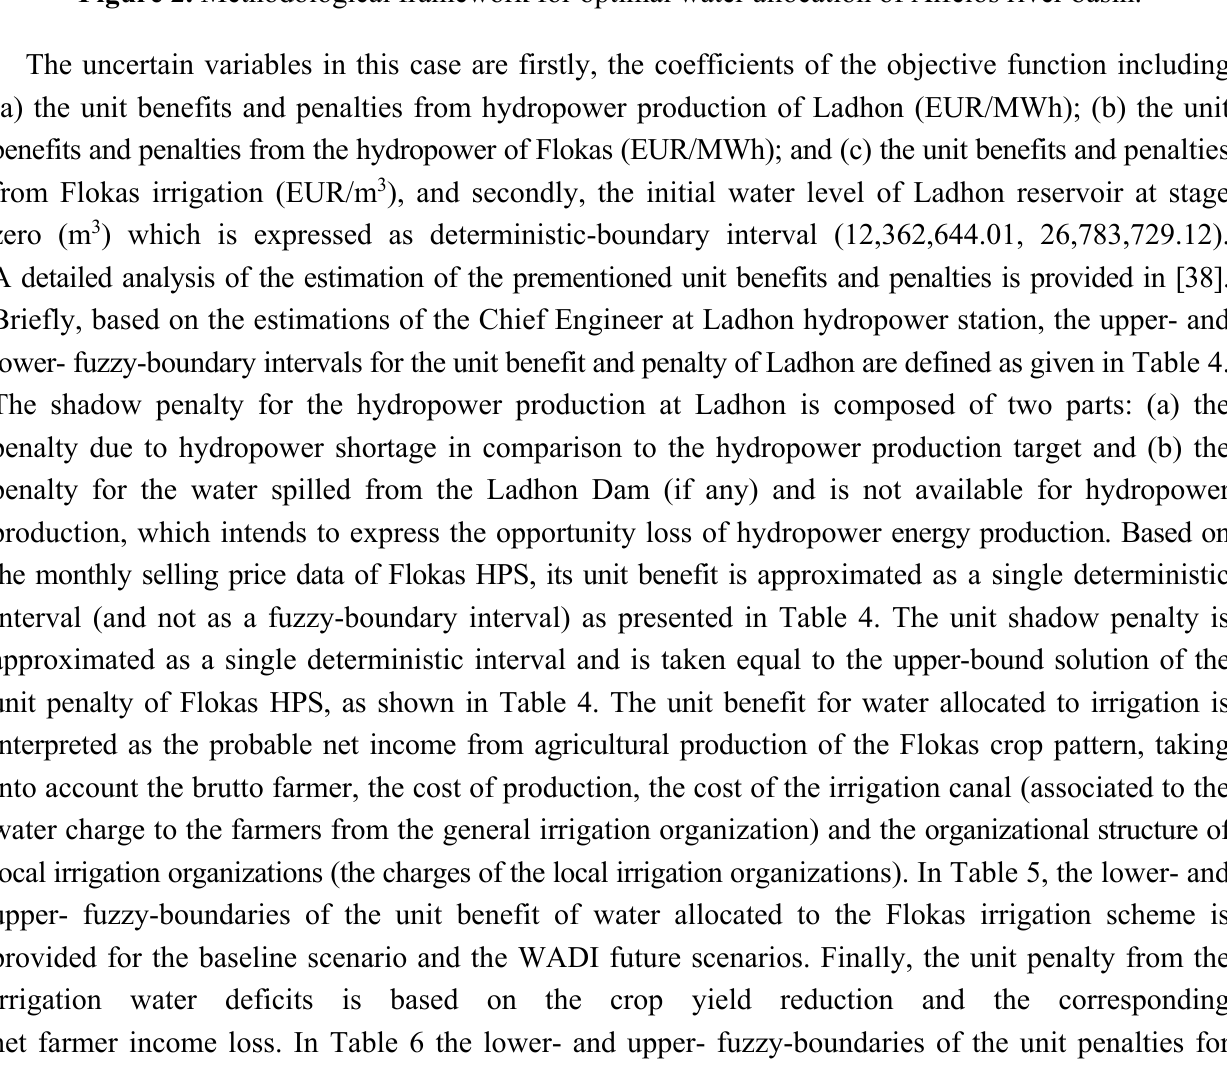
Figure 2. Methodological framework for optimal water allocation of Alfeios river